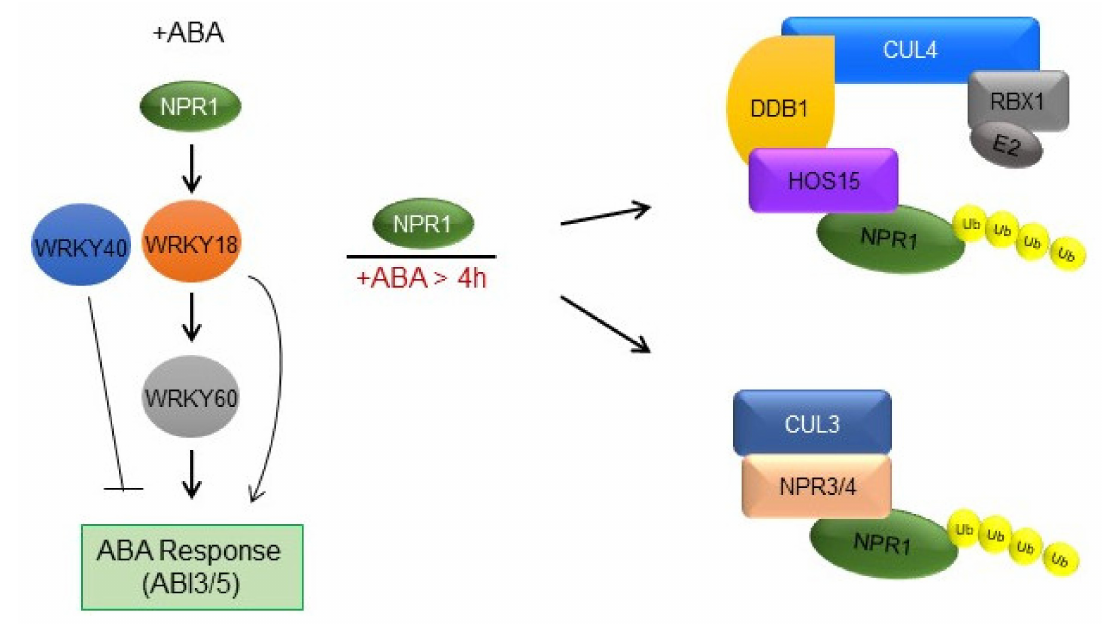
Figure 6. Hypothetical model. During ABA stress, NPR1 regulates ABA-responsive stress-related gene expression and activates WRKY18 , which in turn competes with WRKY40 to regulate WRKY60 and activate the downstream ABA response. However, NPR1 interacts with HOS15, a substrate receptor for the CUL4-DDB1 E3-ligase ubiquitin complex, and gradually, after the activation of the WRKY genes and ABA response, NPR1 is degraded in an ABA-dependent manner. NPR1 is also degraded by CUL3 NPR3/NPR4 E3 ligase complex in an ABA dependent manner [Modified from,